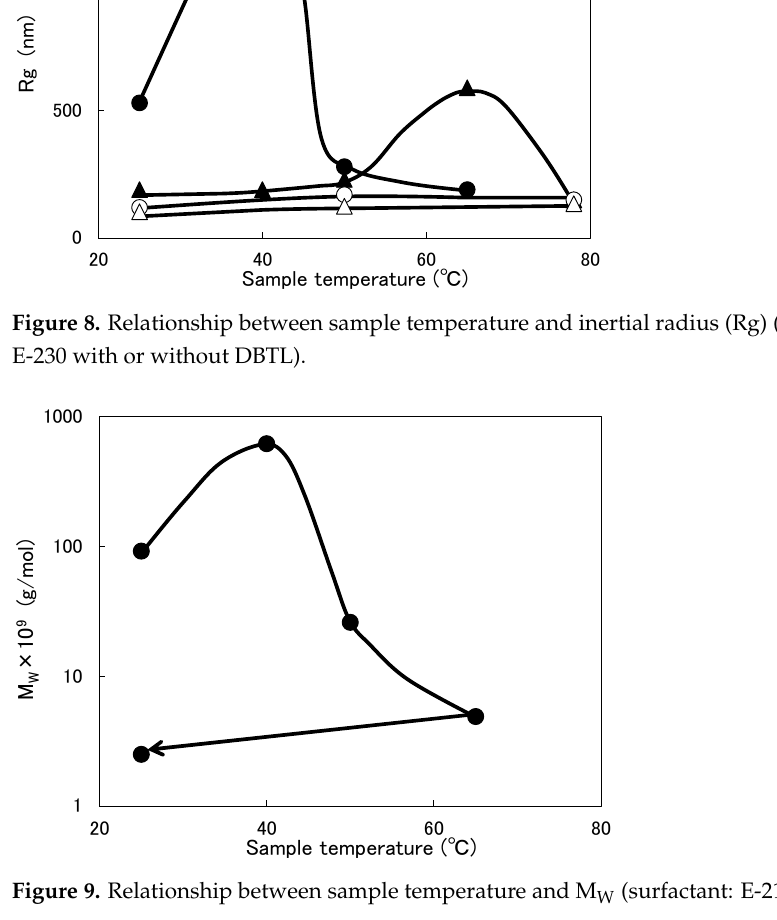
Figure 10. Relationship between sample temperature and Rg (surfactant: E-212 with DBTL). 3.4. Dynamic Properties of Catalyst Figure 11 shows a part of the 1 H-NMR spectrum when the E-212 aqueous solution containing DBTL was heated from room temperature (24 to 25 °C) to 90 °C. This spectrum shows a peak derived from the C(=O)CH 2 group of the DBTL. However, this peak is not distinct between room temperature and 40 °C, and only becomes noticeable at a tempera- ture of 50 °C or higher. This result suggests that the DBTL molecular motion is constrained by the surfactant molecules (micelles) between room temperature and 40 °C, and that the DBTL molecules become less susceptible to such constraints at 50 °C or higher. The tem- perature at which this molecular motion becomes less susceptible to constraint is around 40 °C, i.e., the temperature at which the peak M W and Rg values were obtained in Figures 7 and 8. As described in Section 3.3, this is presumed to be because the DBTL is discharged from the micelles at the peak M W and Rg temperature. Next, Figures 12 and 13 compare the spectra for E-212 and E-230 (both containing DBTL) at 50 and 70 °C, respectively. Fig- ure 12 shows a clear DBTL-derived C(=O)CH 2 group peak for E-212 (the upper spectrum in Figure 12). In contrast, the peak for E-230 contains a shoulder and is slightly less distinct (the lower spectrum in Figure 12). One reason for this may be as follows. Considering the different peak M W and Rg temperatures for E-212 and E-230 in Figures 7 and 8, most of the DBTL has probably been discharged from the micelles at 50 °C in the case of E-212. However, at the same temperature, almost all of the DBTL probably remains constrained by the micelles in the case of E-230. However, it is difficult to make a definite judgement.